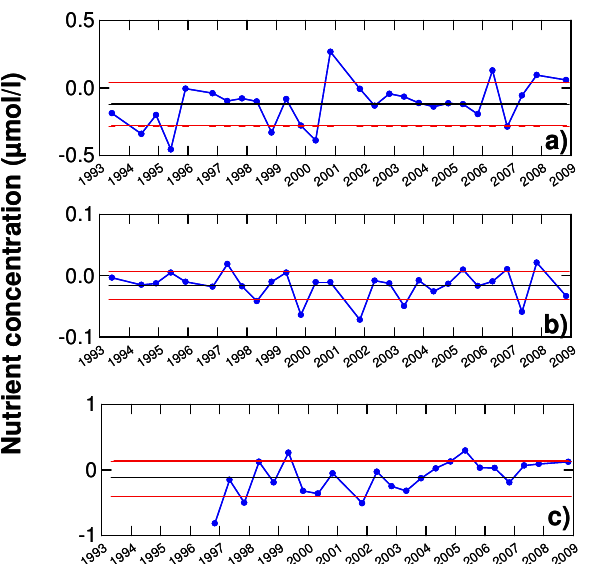
Figure 2. Average MRI-IS di ff erences of (a) nitrate, (b) phosphate and (c) silicate concentrations (in µ mol / l) from assigned values in QUASIMEME sea water test materials 1993–2008 (silicate from 1996). The overall long term mean deviations are shown with black slashed lines and their standard deviations are shown with a red dotted line.